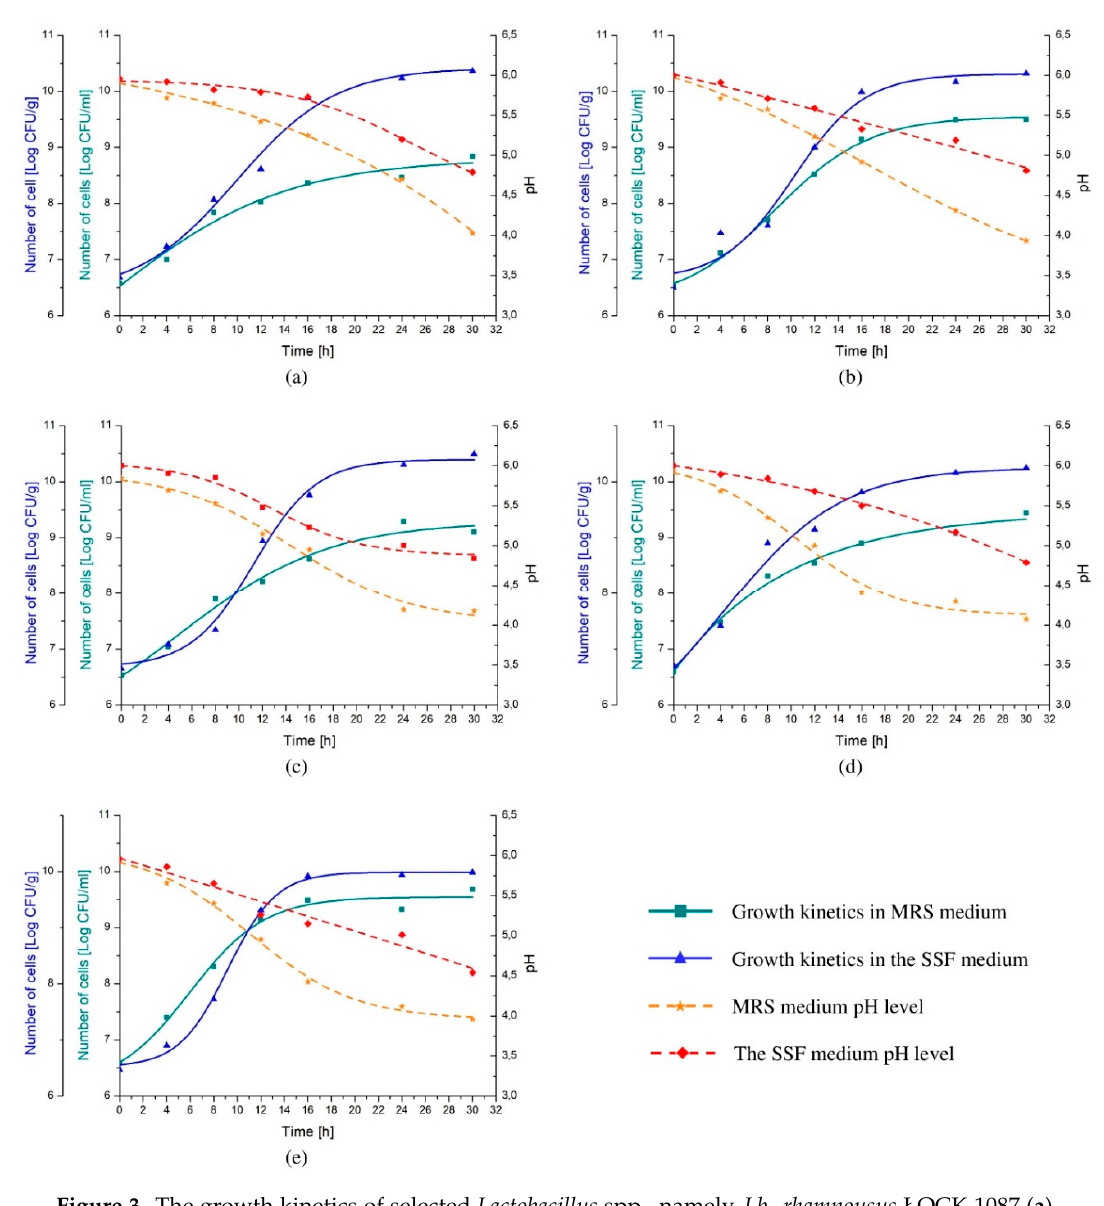
Figure 3. The growth kinetics of selected Lactobacillus spp., namely, Lb. rhamnousus ŁOCK 1087 ( a ), Lb. paracasei ŁOCK 1091 ( b ), Lb. reuteri ŁOCK 1092 ( c ), Lb. plantarum ŁOCK 0860 ( d ) and Lb. pentosus ŁOCK 1094 ( e ) cultivated in the semi-solid fermentation (SSF) medium or de Man, Rogosa, and Sharpe (MRS) broth, comparatively. Results are presented as the logarithm of colony-forming units per gram (Log CFU/g) or milliliter (Log CFU/mL).